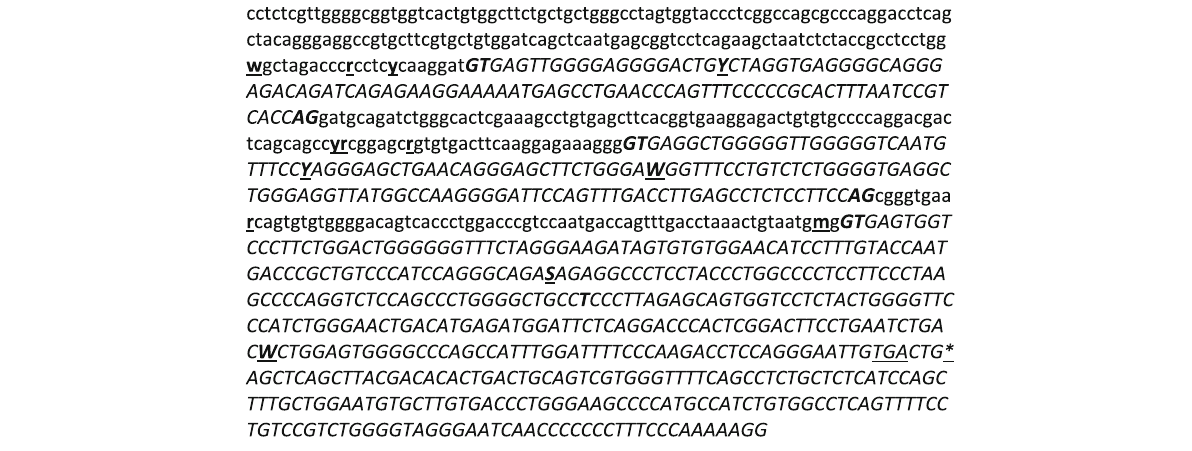
Fig. 2 Buffalo CATH4 unspliced cDNA sequence. Starting position is c.21. Introns are in italic with the 5 ′ and 3 ′ splice site (GT-AG). Exons 1, 2 and